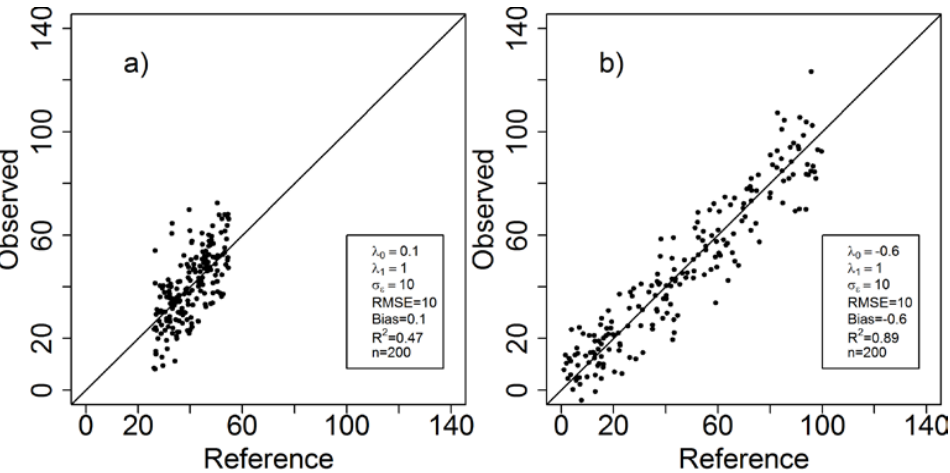
Figure 2. An illustration of how R 2 changes depending on how the n = 200 data points are distributed at a given constant residual variance. Despite the same RMSE, R 2 = 0.47 in ( a ) and R 2 = 0.89 in ( b ).